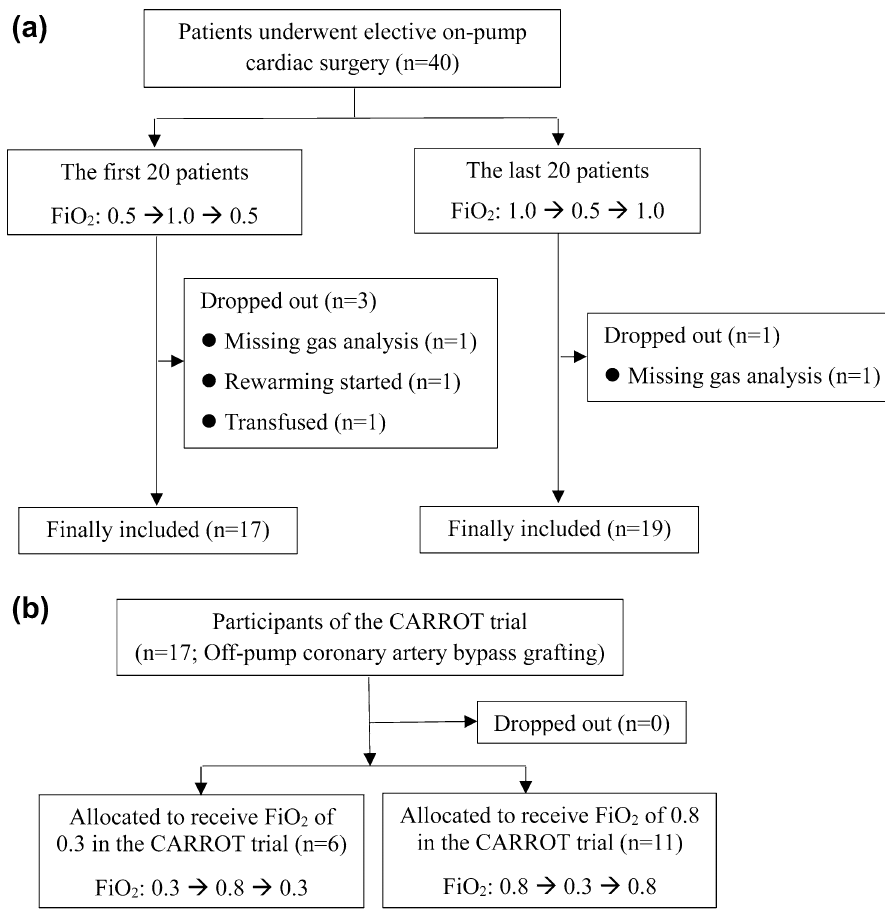
Figure 1. Study flow chart of ( a ) on-pump and ( b ) off-pump patients. FiO 2 , fraction of inspired